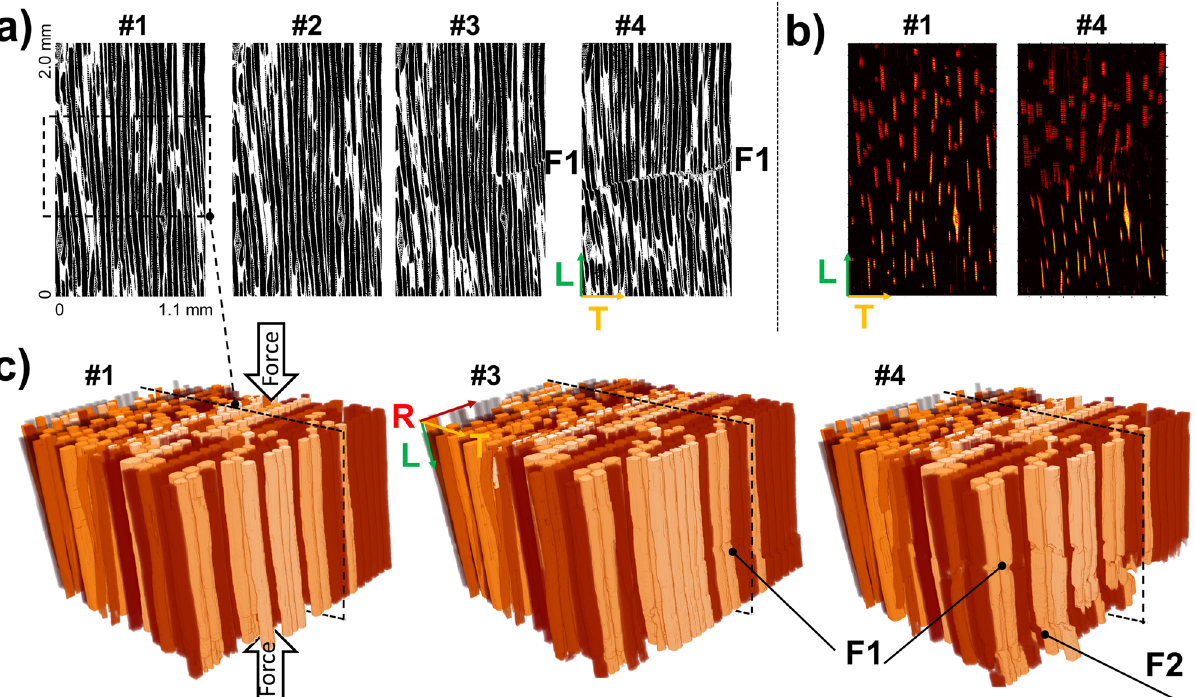
Figure 6. ICT for longitudinal compression experiment (L-specimen). ( a ) In-situ LT slices for deformation states #1 (baseline), #2 (elastic deformation), #3 (plastic onset), and #4 (densification). ( b ) LT projection of segmented wood rays. ( c ) Three-dimensional render of segmented tracheids. Co-registered cells are painted with the same color. In #3, the fracture plane F1 starts developing. With additional compression #4, F1 extends over the specimen cross-section and to an additional plane